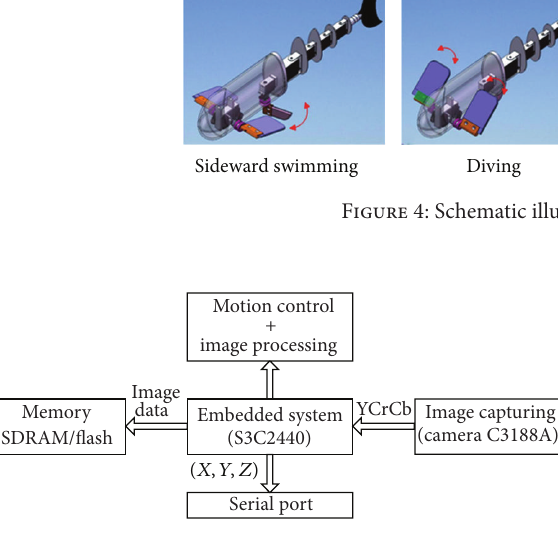
Figure 5: Hardware architecture of the adopted embedded